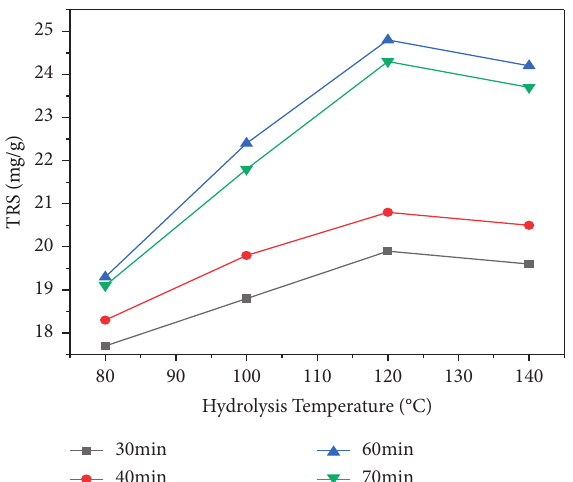
Figure 4: The effect of hydrolysis temperature and hydrolysis time on the yield of total reducing sugar (TRS) from Teff straw (dilute sulfuric acid concentration � 4 v/v (%) and solid to liquid ratio � 1:20).